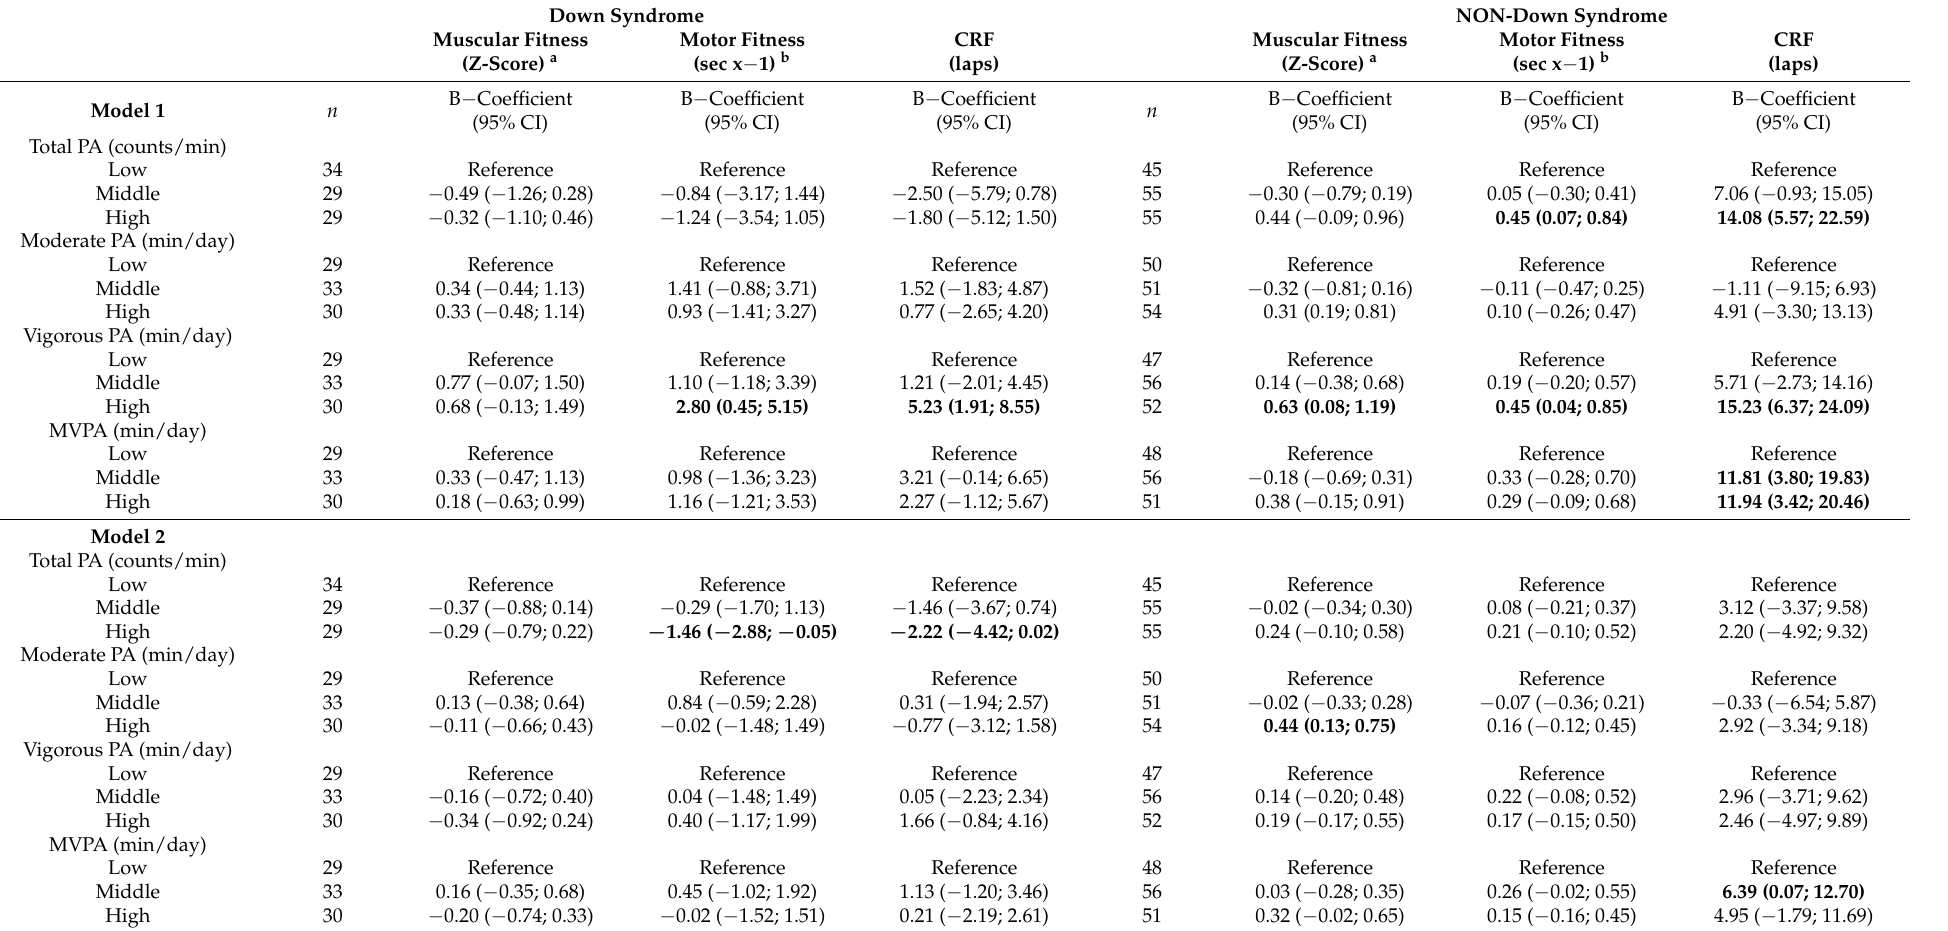
Table 2. Associations of tertiles of physical activity at baseline and health-related physical fitness at 2-year follow-up in adolescents with and without Down